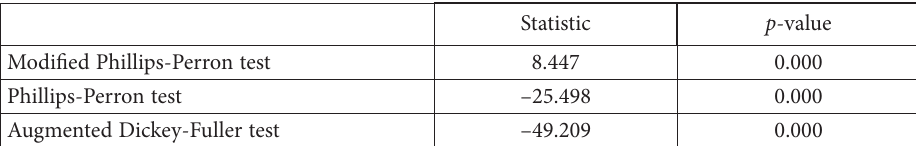
Table 3. Pedroni cointegration test for 2011–2017 model (source: compiled by the